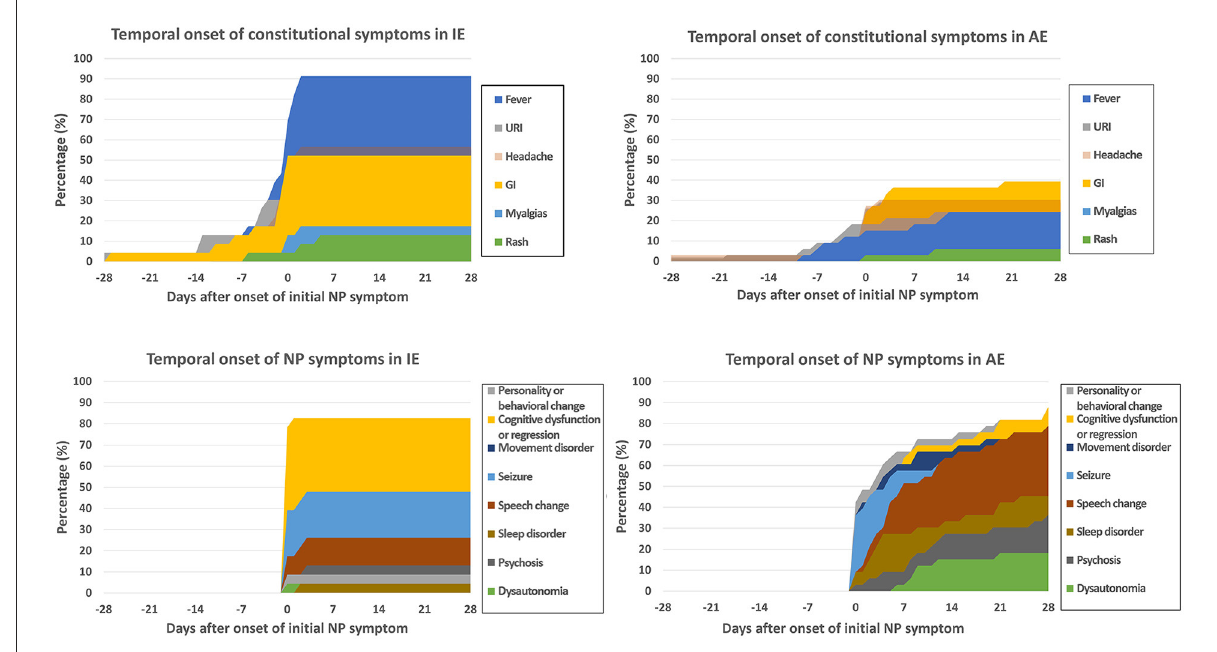
FIGURE2 Temporal onset of constitutional and NP symptoms in IE and AE. Graphs present cumulative percentage of patients with each individual symptom relative to onset of initial NP symptom (Day 0).